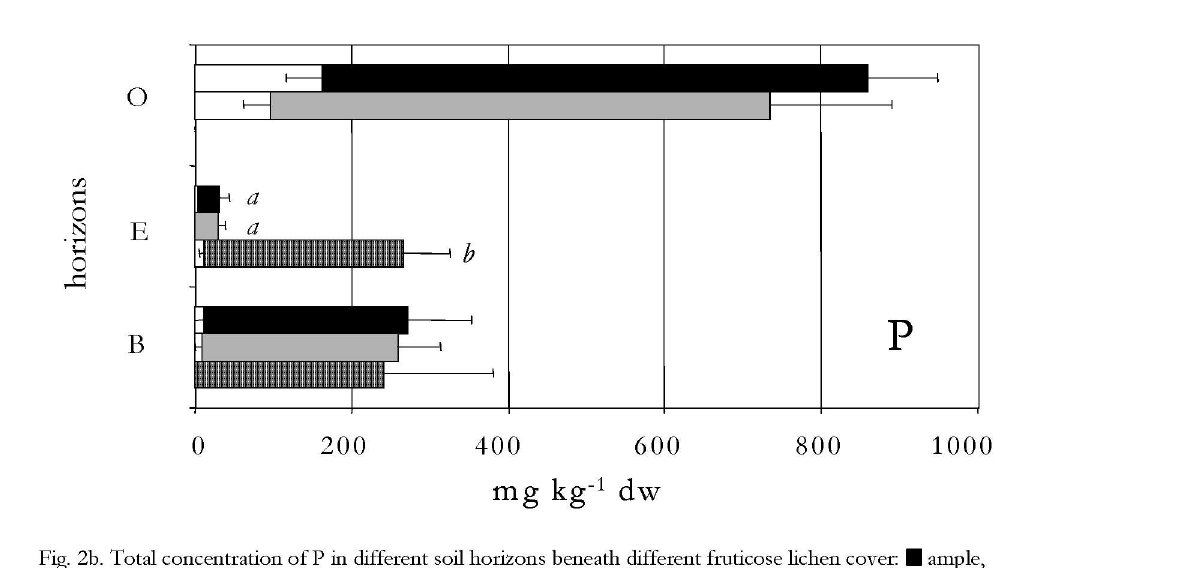
Fig. 2b. Total concentration of P in different soil horizons beneath different fruticose lichen cover: H ample, CD reduced, E poor. CD indicates plant available concentrations of P. Significant differences (P<0.05) between plots with different lichen cover are indicated by letters.